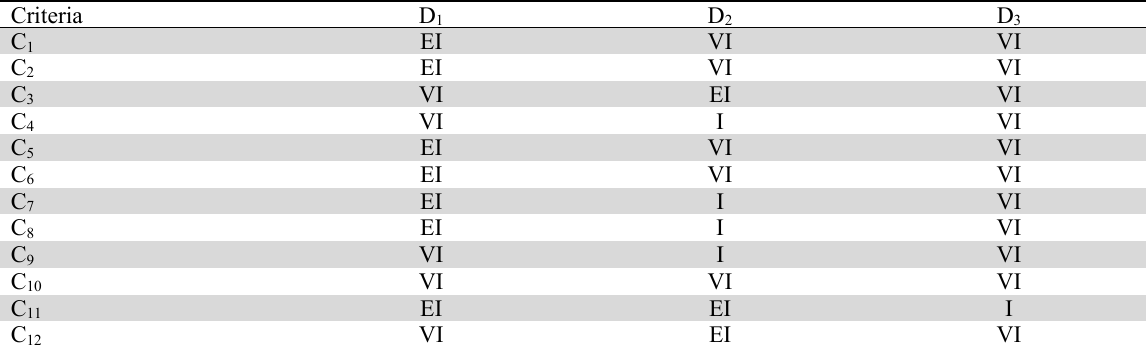
Linguistic values of the criteria